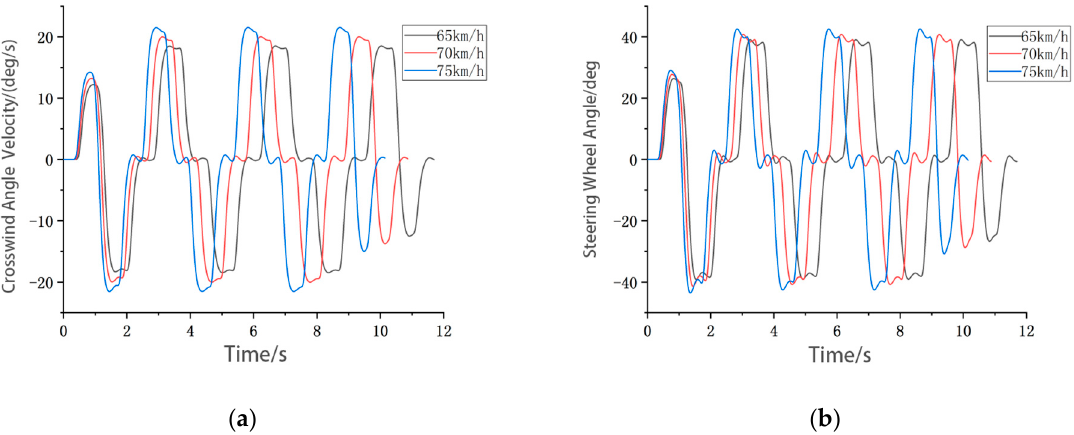
Figure 13. Peak curve without crosswind effect: ( a ) average crosswind angle velocity and ( b ) average steering-wheel angle. Table 8. Performance indexes of snaking test at 65, 70 and 75 km/h without crosswind.